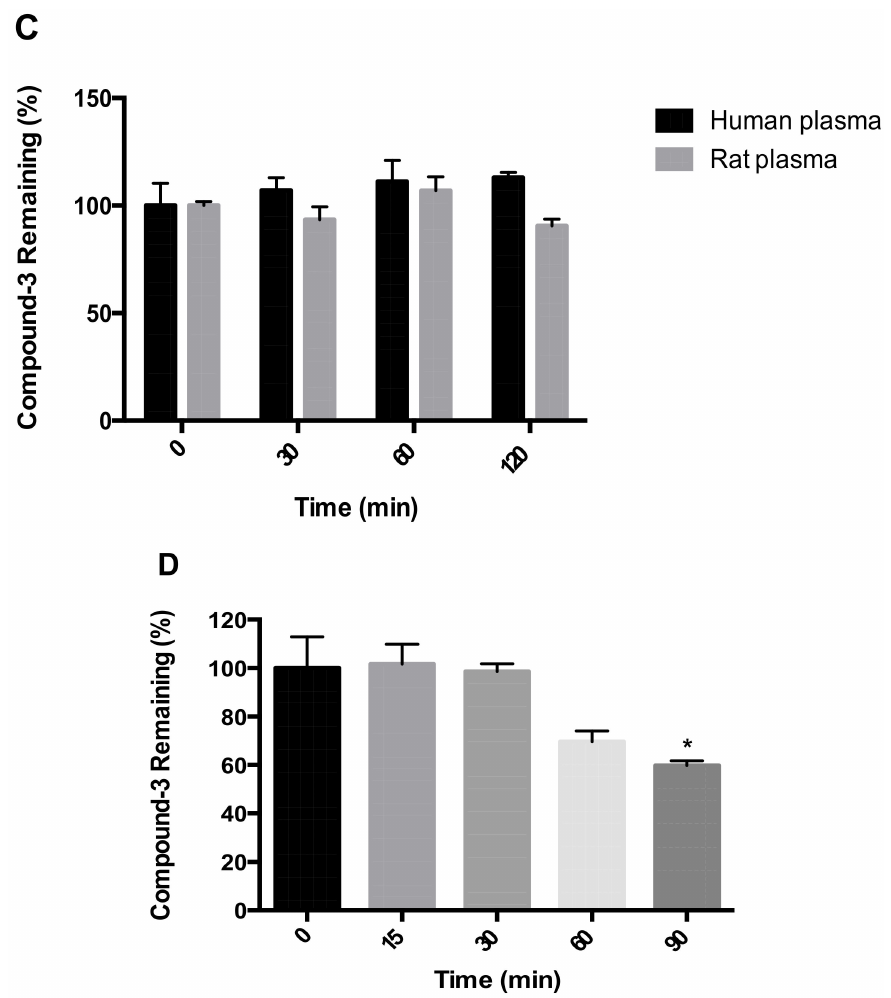
Figure 2. In vitro metabolic stability of Compound- 3 . HLM and HIM ( A ); RLM and RIM ( B ); Rat and human plasma ( C ); Human hepatocytes ( D ). Compound- 3 (1 µ M) was incubated with liver microsomes (0.2 mg/mL) in the absence and presence of NADPH, plasma and hepatocytes (1 × 10 6 cell/mL) at 37 ◦ C (n = 3). * P < 0.05 vs. Compound- 3 remaining (100%) at 0